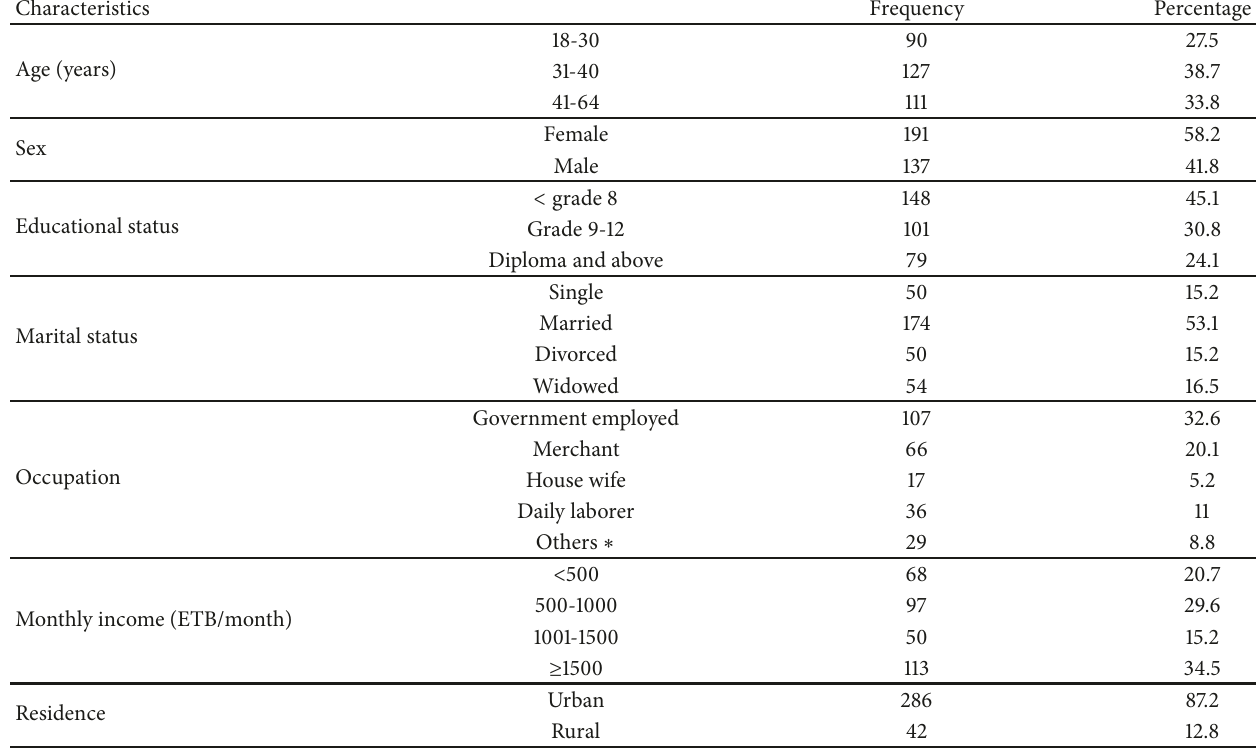
Table 1: Sociodemographic characteristics of HIV-positive patients attending Jimma University Medical Center, Jimma, Ethiopia, 2018 (N=